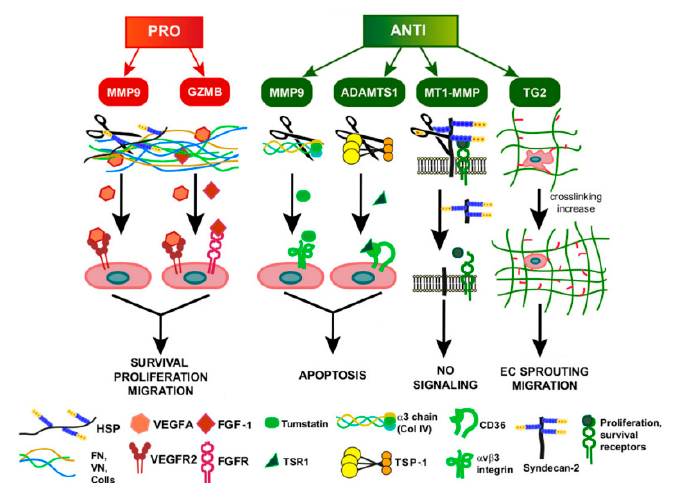
Figure 3. Schematic representation of the role of ECM remodeling in GI tumor-associated angiogenesis. The drawing exemplifies the action of proteases in a ff ecting EC behavior and leading to pro-angiogenic (red) or anti-angiogenic (green) e ff ects. The scheme summarizes the major molecules exerting these functions in the context of GI